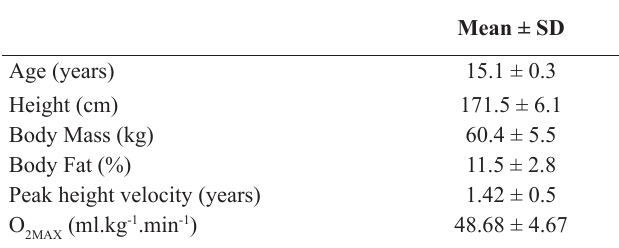
Table 1. Sample characteristics expressed in mean ± sd of age, height, body mass, body fat, peak height velocity and O